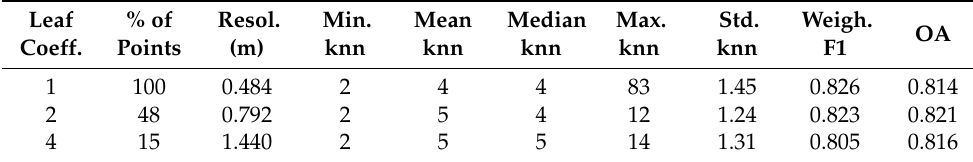
Table 4. Density analysis on LASDU dataset.